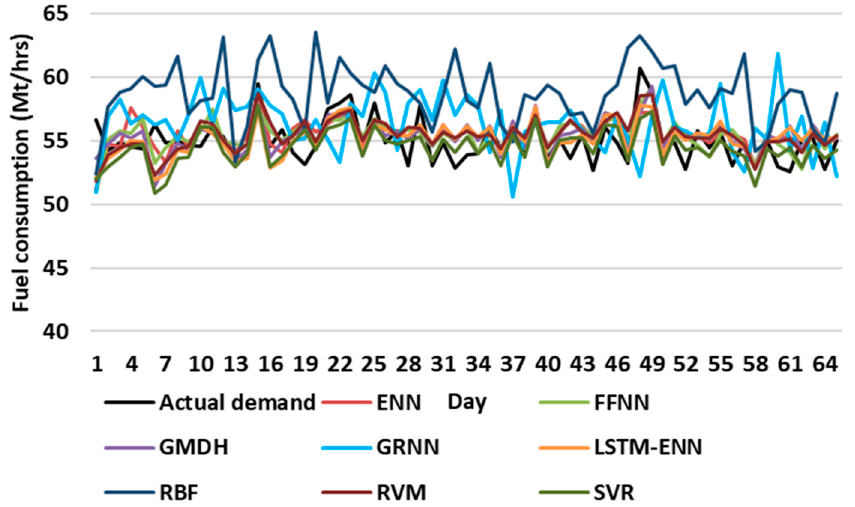
Figure 15. Actual demand and forecasts for Test Case #3.